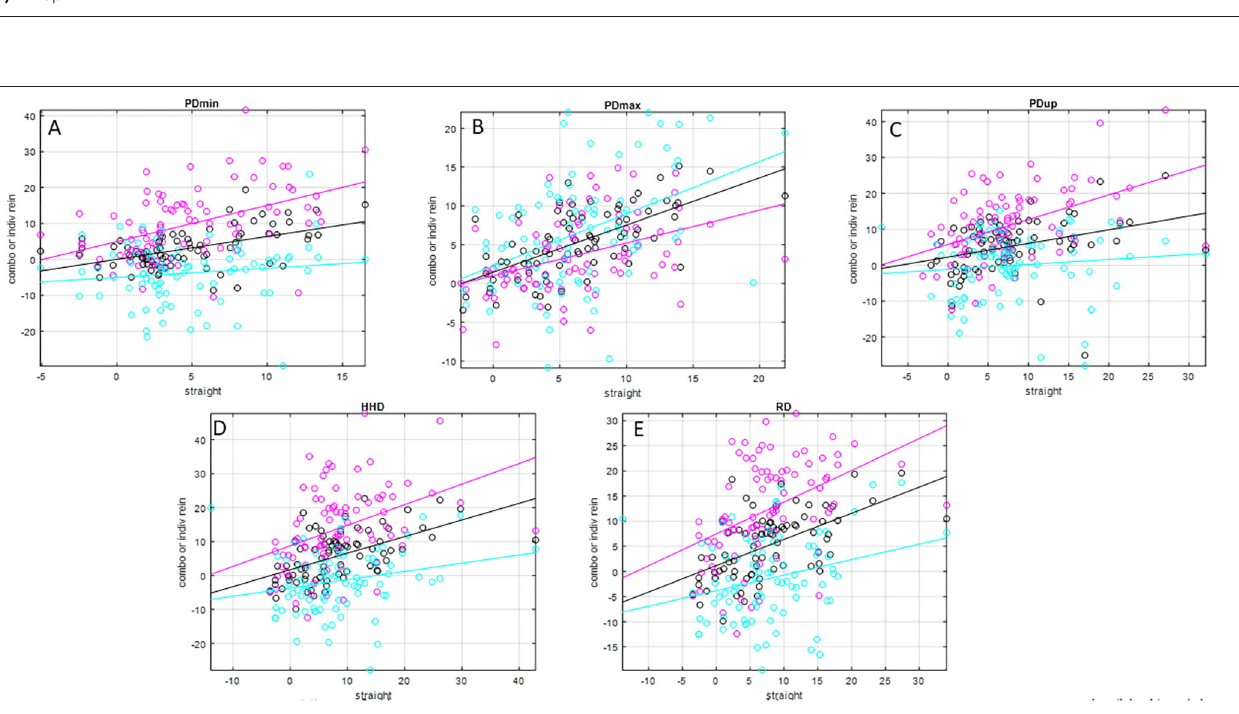
FIGURE 2 | Scatter plots and linear trend lines of pairs of matching straight-line and individual rein (inside rein: magenta; outside rein: cyan) average-rein (black) pelvic movement asymmetry values for N = 79 pairs of asymmetry values for N = 26 horses (one horse did not have matching straight-line and average-rein asymmetry values). Please see Table 2 for values of slope, intercept, and R 2 values. (A) PDmin, (B) PDmax, (C) PDup, (D) HHD, (E)